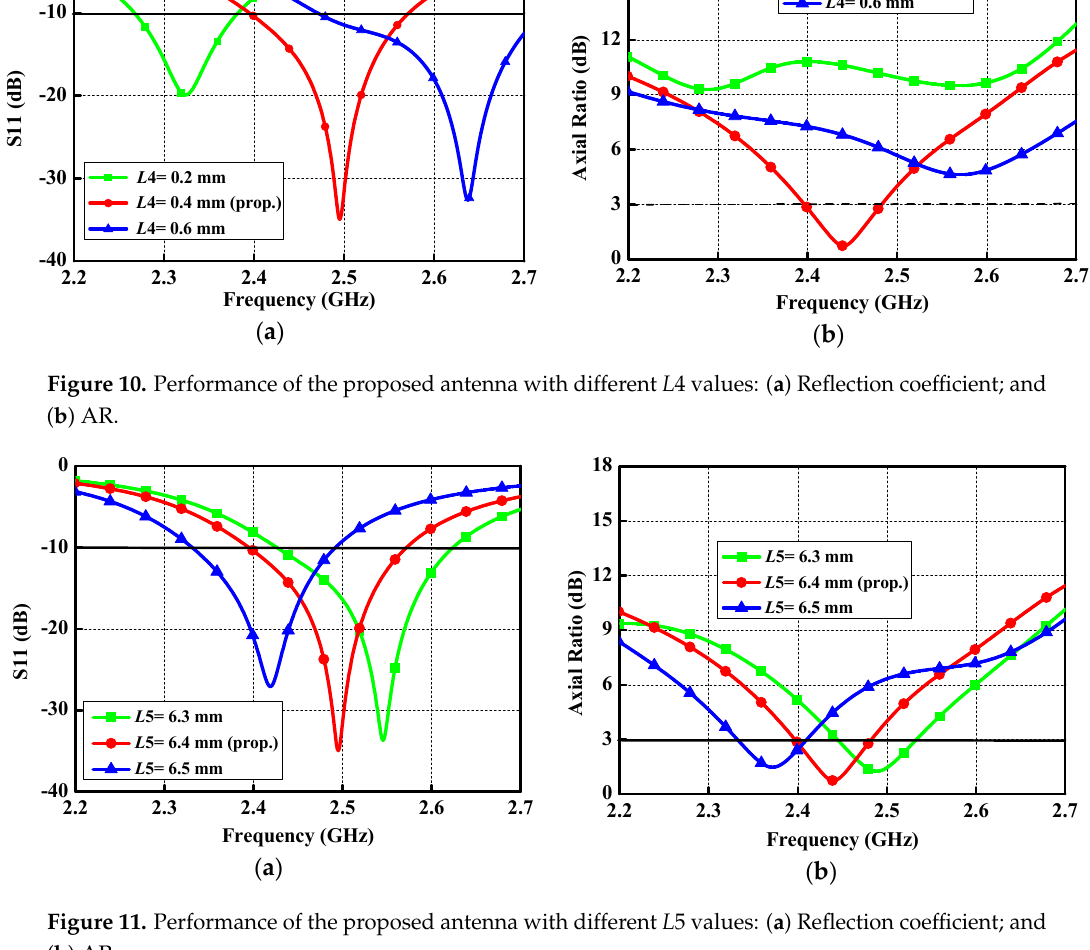
Figure 11. Performance of the proposed antenna with different L 5 values: ( a ) Reflection coefficient; and ( b ) AR.